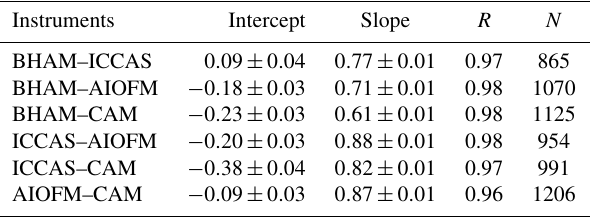
Table 2. Results of the reduced major axis regression analysis with 95% confidence intervals during the formal winter intercompari- son. Variability shown is the 95% confidence interval of the slope and intercepts.